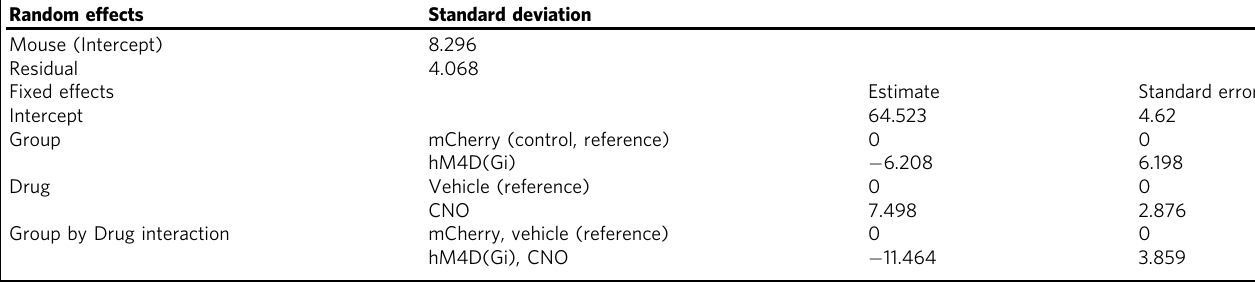
Table 1 LME model: effect of chemogenetic inhibition of VM on wake duration Random effects